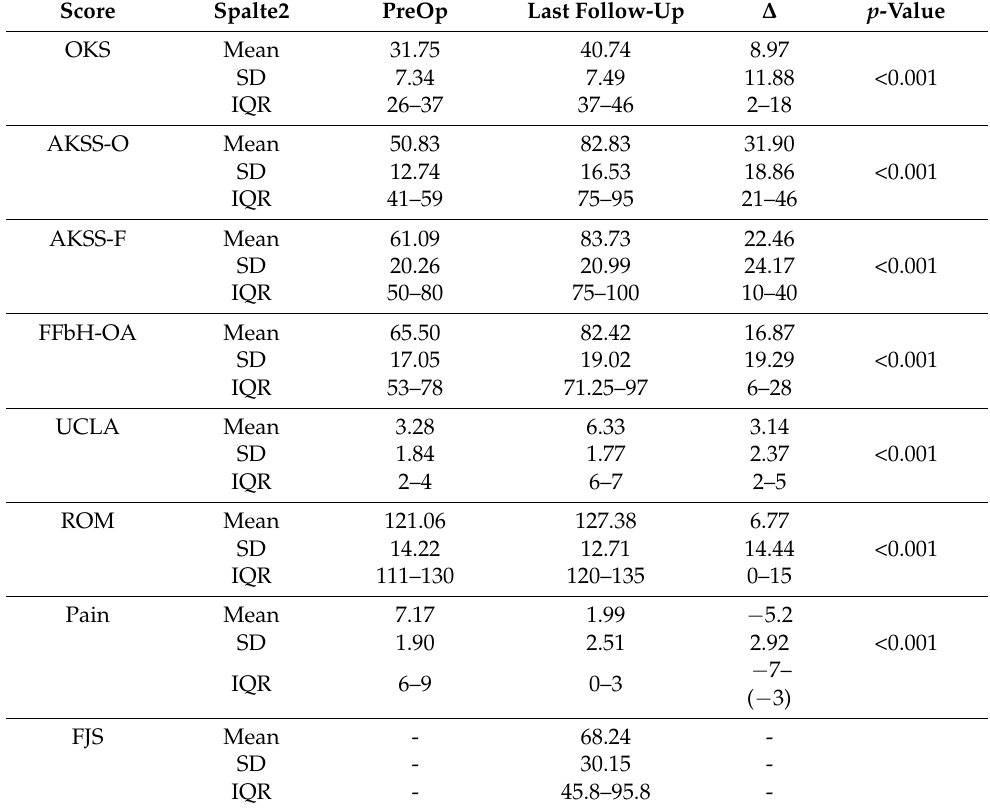
Table 1. Functional